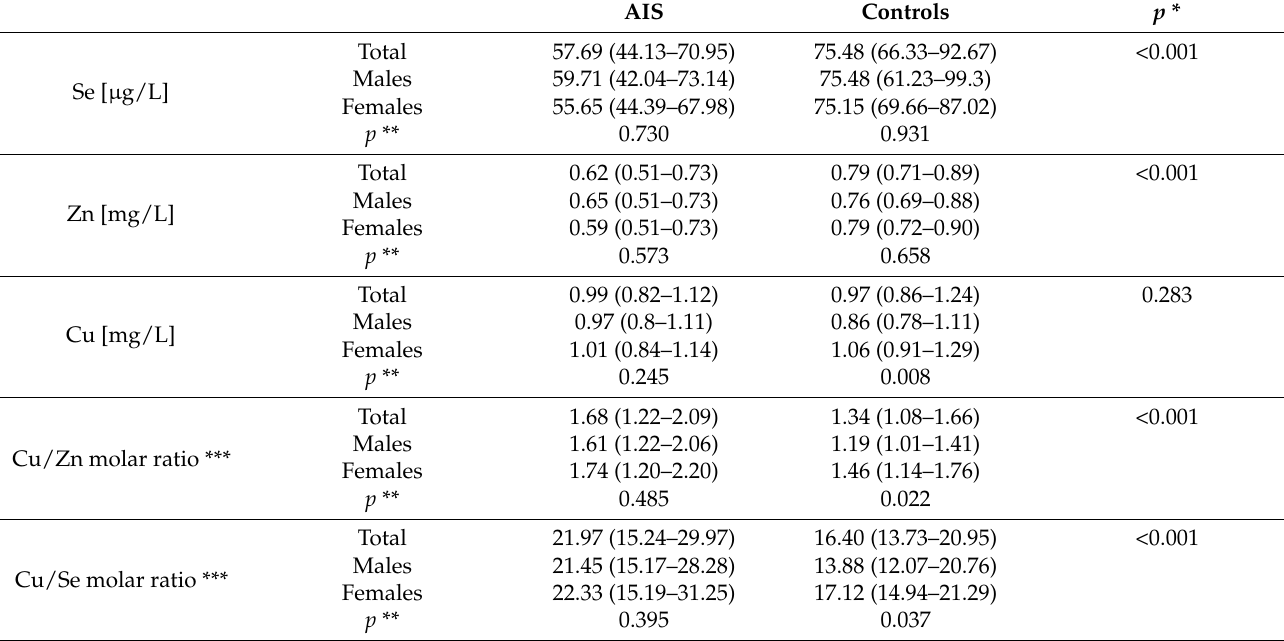
Table 2. Trace elements status of the study population.